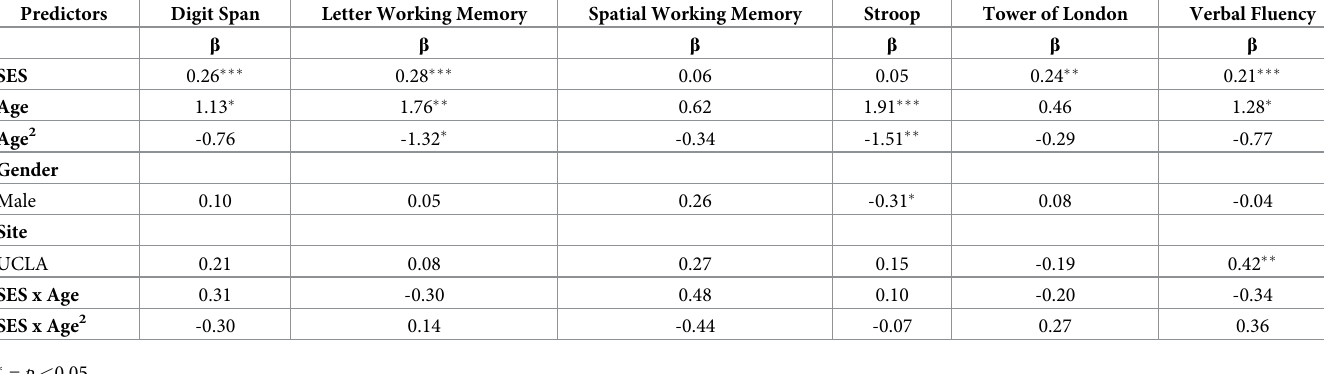
Table 9. Multiple regression analyses of EF measures on SES ( N =